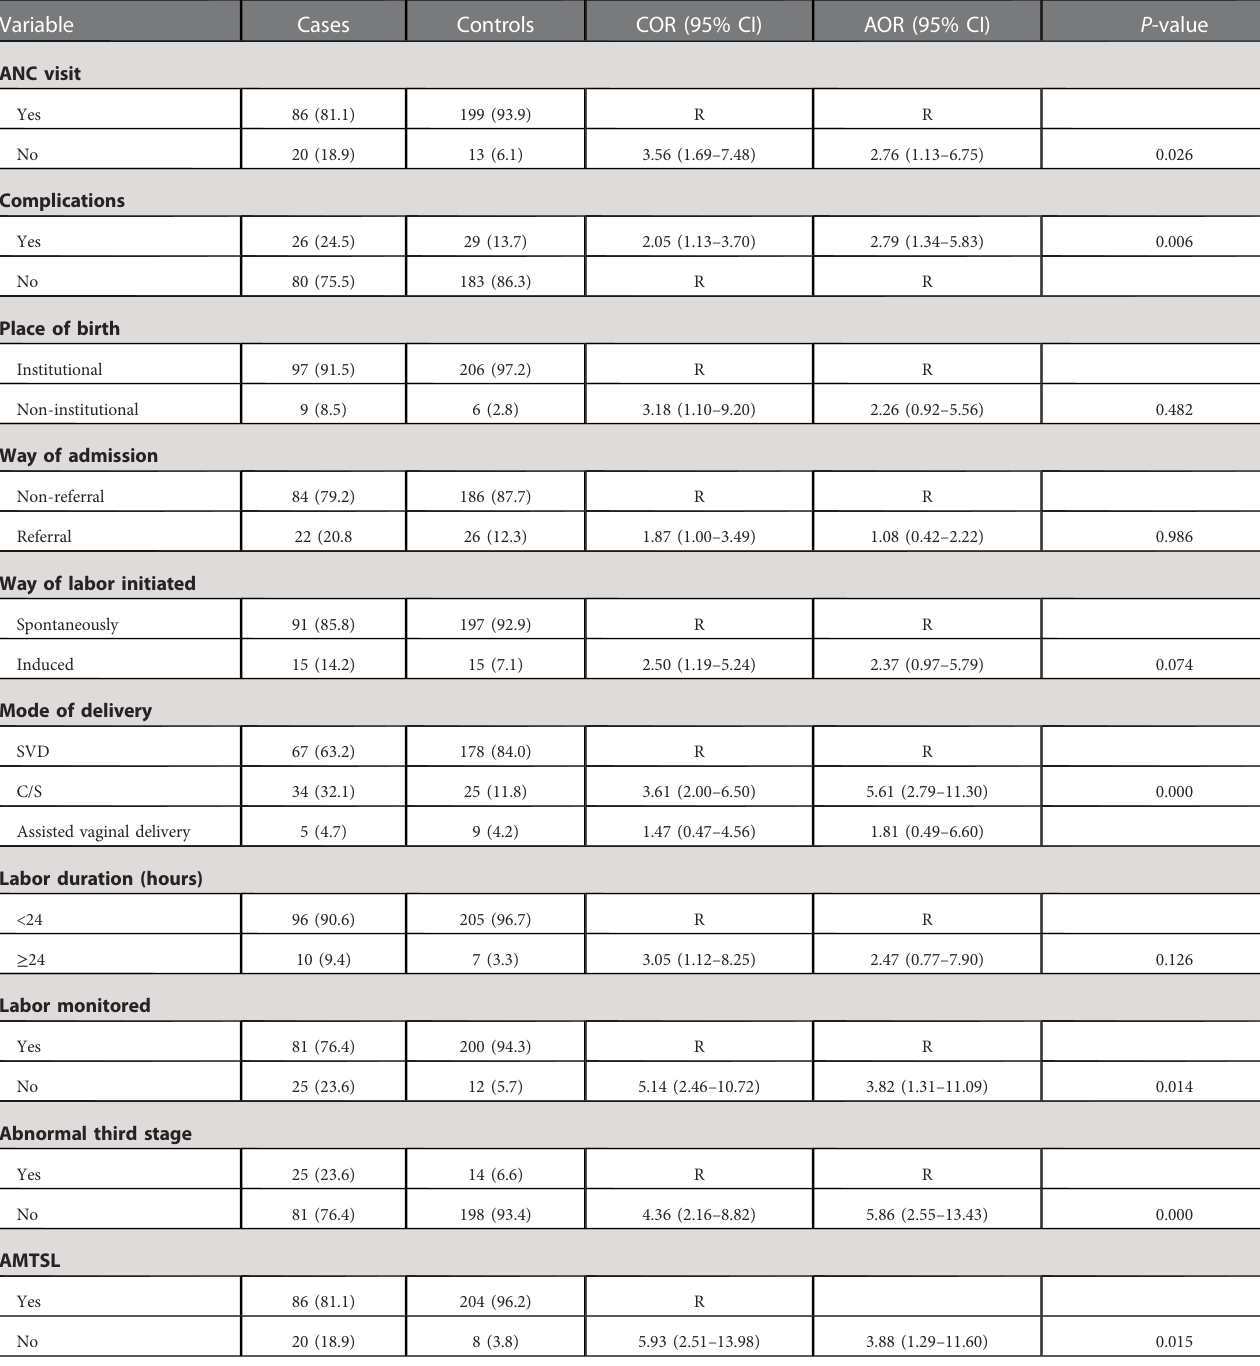
TABLE 5 Multivariate analysis of the association between independent factors and primary postpartum hemorrhage among postnatal mothers in a public hospital in southern Tigray, Ethiopia, 2019.